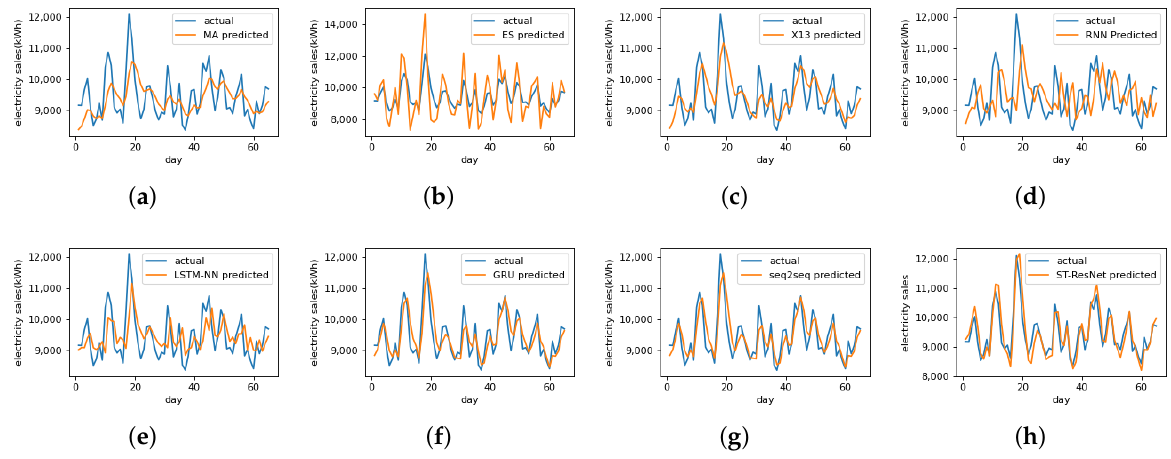
Figure 9. Comparison of short-term forecasting: ( a ) MA; ( b ) ES; ( c ) X13; ( d ) RNN; ( e ) LSTM-NN; ( f ) GRU; ( g ) Seq2Seq; ( h ) ST-ResNet.